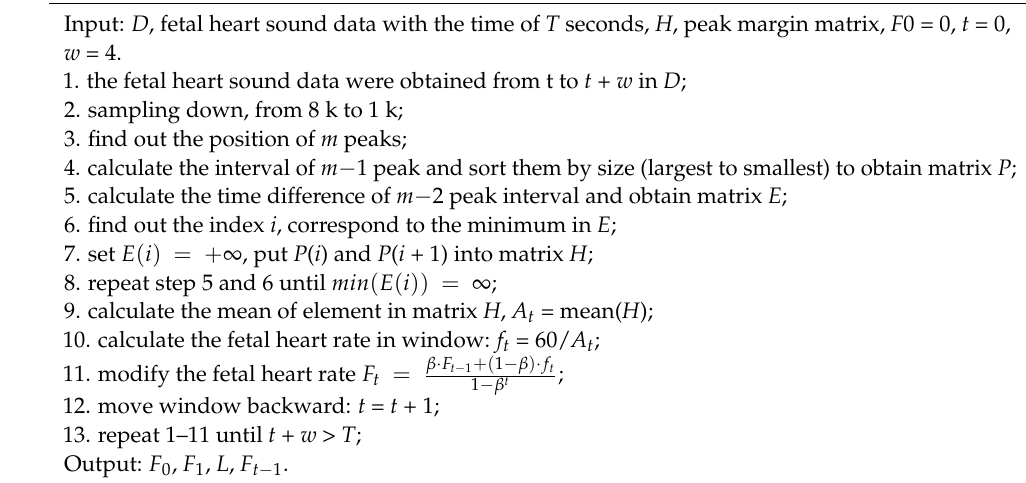
Algorithm 1: Proposed Fetal Heart Rate Extraction